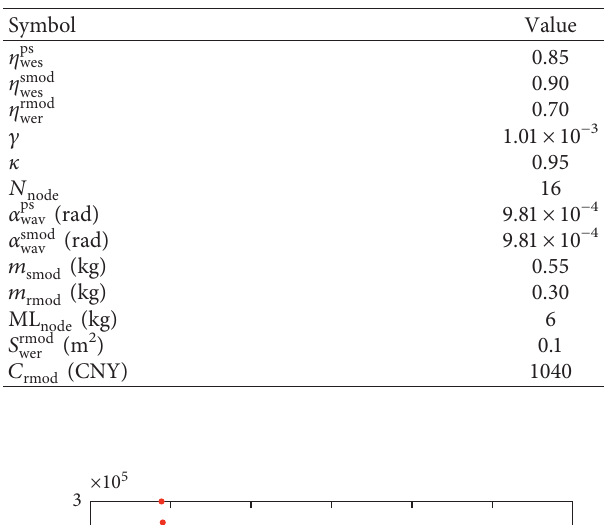
Table 1: Experimental parameters.